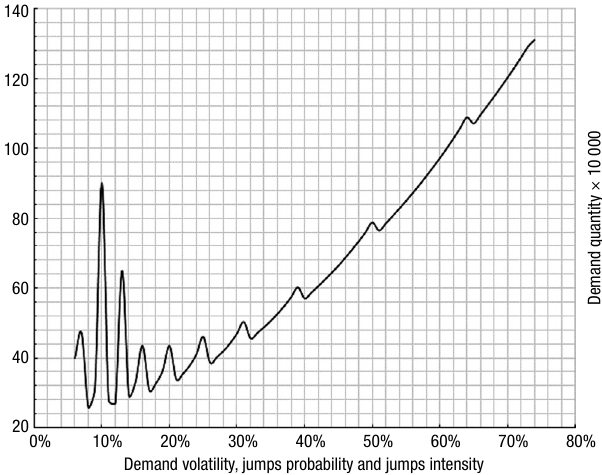
Fig. 4. Simulation of the trigger moment for the change of EM, considering different demand volatility levels, jumps probability and intensity levels